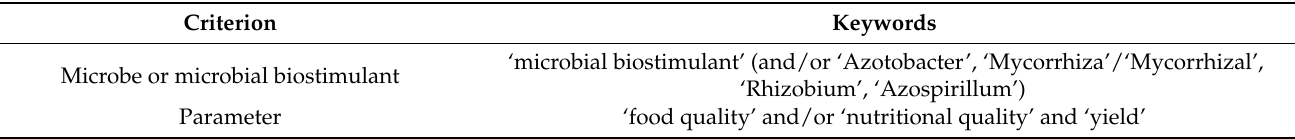
Table 1. Article screening criteria and key